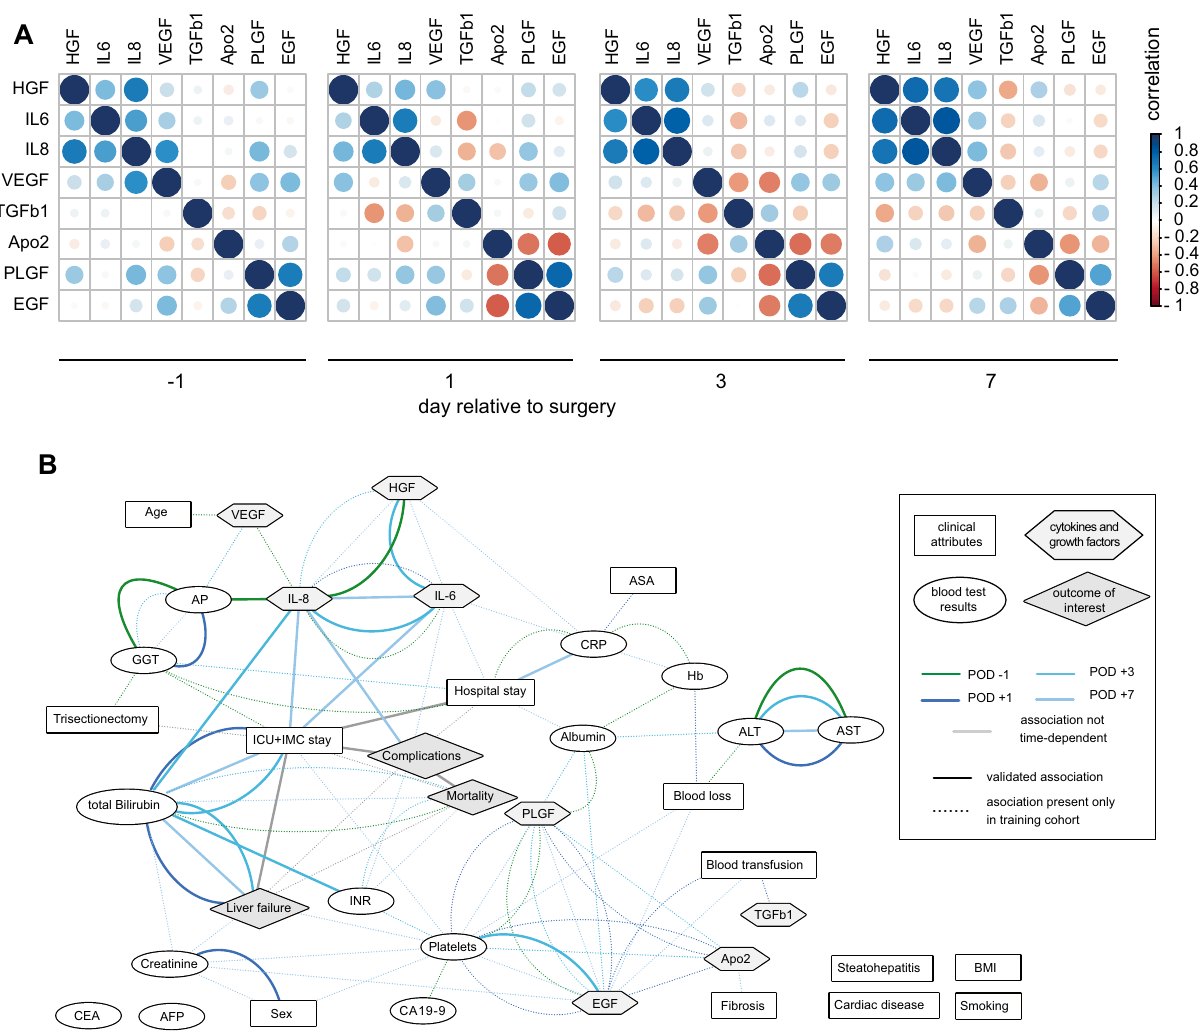
Figure 4. Timepoint dependent cytokine and growth factor concentrations and association among plasma proteins and clinical attributes. ( A ) Pairwise correlation of cytokine and growth factor concentrations separated by time points. ( B ) Global association network of known and novel study parameters. Oval nodes display the laboratory values, rectangular nodes the clinical information, hexagonal nodes cytokines or growth factors, and the diamond-shaped outcome parameter of interest. Every line indicates a significant association between two nodes. Dotted lines show association in training cohort data, solid lines associations validated in the validation data. PHLF numerical and categorized showed exact same interactions and were combined as PHLF for easier